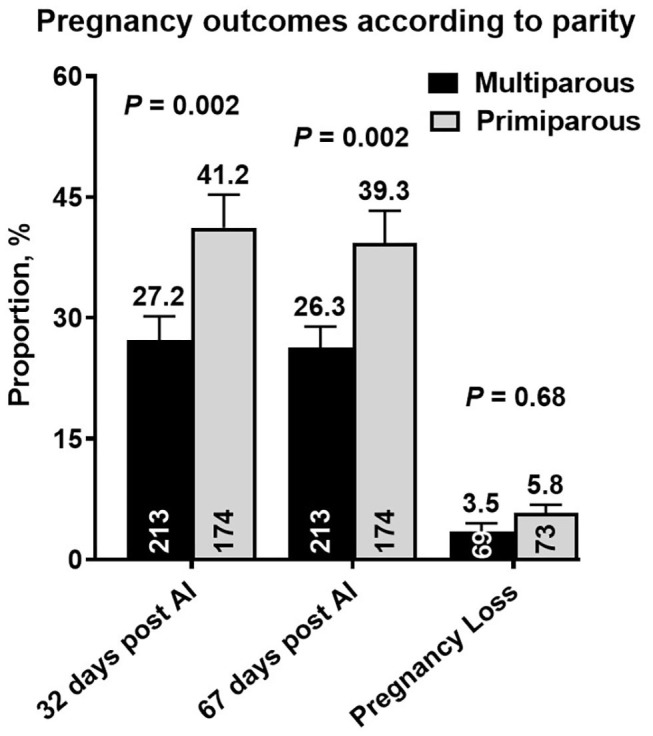
Bar graph illustrating the proportion of pregnant cows at days 32 and 67 post-AI and proportion of pregnancy loss according to the effects of parity (Multiparous vs. Primiparous). The mean proportion for each bar is listed above each error bar, whereas the number of cows per treatment is at the bottom of each bar. Error bars represent the standard error of the mean.